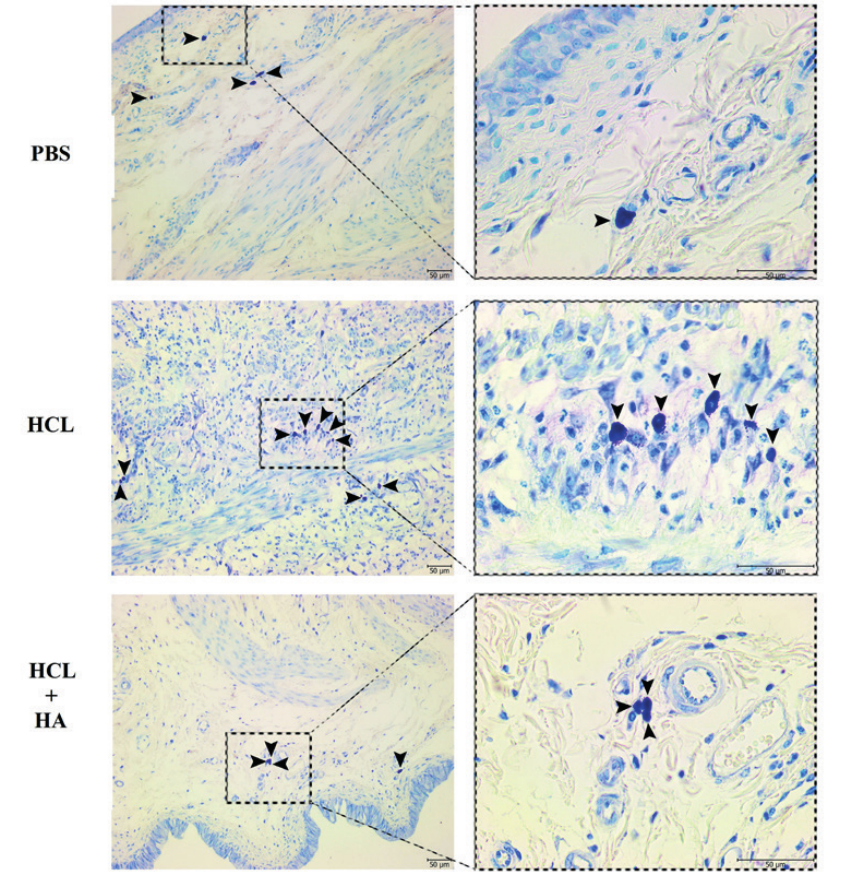
figure 2 - Image representing mast cell count between three groups. Arrowhead shows mast